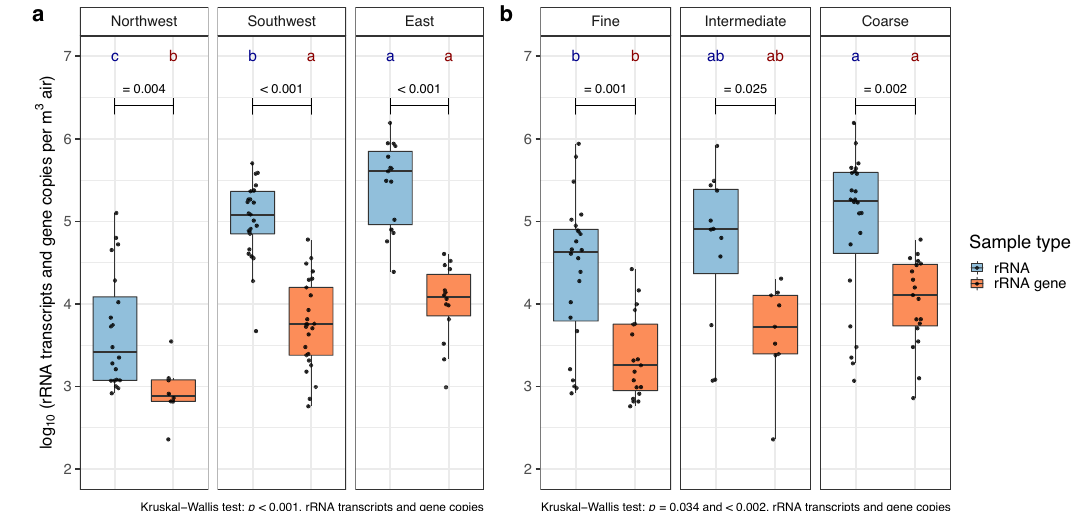
Fig. 2 Abundance of airborne bacterial communities. The rRNA transcripts and gene copies in different air masses ( a ), and particulate matter size classes ( b ). Box plot center lines represent the median values, the lower and upper hinges correspond to the fi rst and third quartiles (the 25th and 75th percentiles), the lower and upper whisker extends from the hinge to the lowest and largest value no further than 1.5 * IQR from the hinge, and dots represent individual samples within each group. Lowercase letters indicate signi fi cant differences ( p < 0.05) between the air masses and particle-size classes for rRNA transcripts and gene copies, separately. p values of signi fi cance between rRNA transcripts and gene copies in each air mass and particle- size class are displayed over the horizontal bars in each